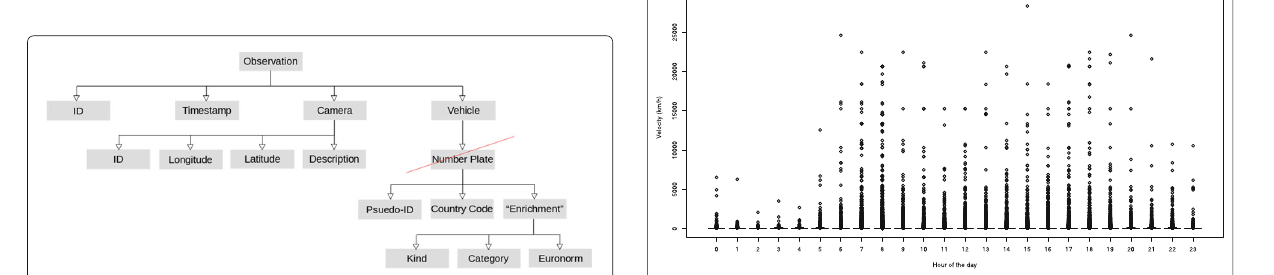
Fig. 2 Attributes of the augmented ANPR camera